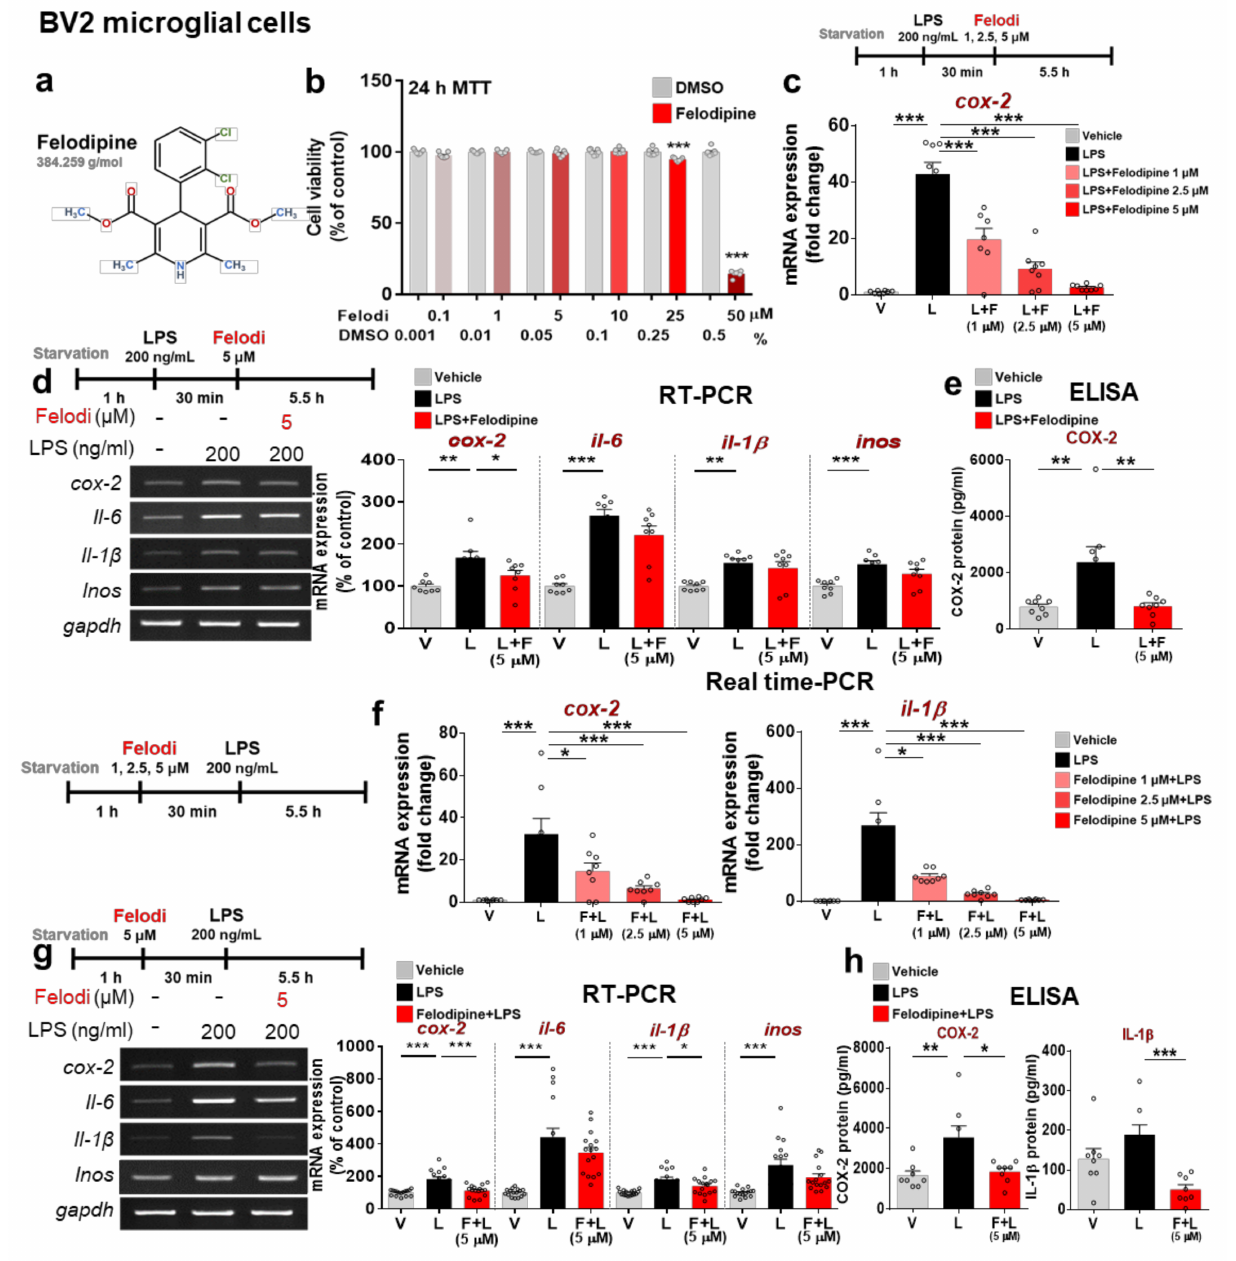
Figure 1. The L-type Ca 2+ channel blocker felodipine suppresses LPS-induced proinflammatory cytokine levels in BV2 microglial cells. ( a ) Structure of felodipine. ( b ) MTT assay of the effect of felodipine on cell viability (felodipine: n = 7/group). ( c ) BV2 microglial cells were treated with LPS, followed by felodipine (1, 2.5, or 5 µ M) as shown, and real-time PCR was performed (n = 8/group). ( d ) BV2 microglial cells were treated with LPS, followed by 5 µ M felodipine as shown, and RT-PCR was conducted (n = 8/group). ( e ) ELISA analysis of the effect of felodipine post-treatment on secreted COX-2 levels (n = 8/group). ( f ) BV2 microglial cells were pre-treated with felodipine (1, 2.5, or 5 µ M), followed by LPS as shown, and real-time PCR was performed (n = 8/group). ( g ) BV2 microglial cells were pre-treated with 5 µ M felodipine, followed by LPS as shown, and RT-PCR was conducted (n = 16/group). ( h ) ELISA analysis of the effect of felodipine pre-treatment on secreted COX-2 and IL-1 β levels (n = 8/group). * p < 0.05, ** p < 0.01, *** p < 0.001. V: vehicle; L: LPS; F or Felodi: